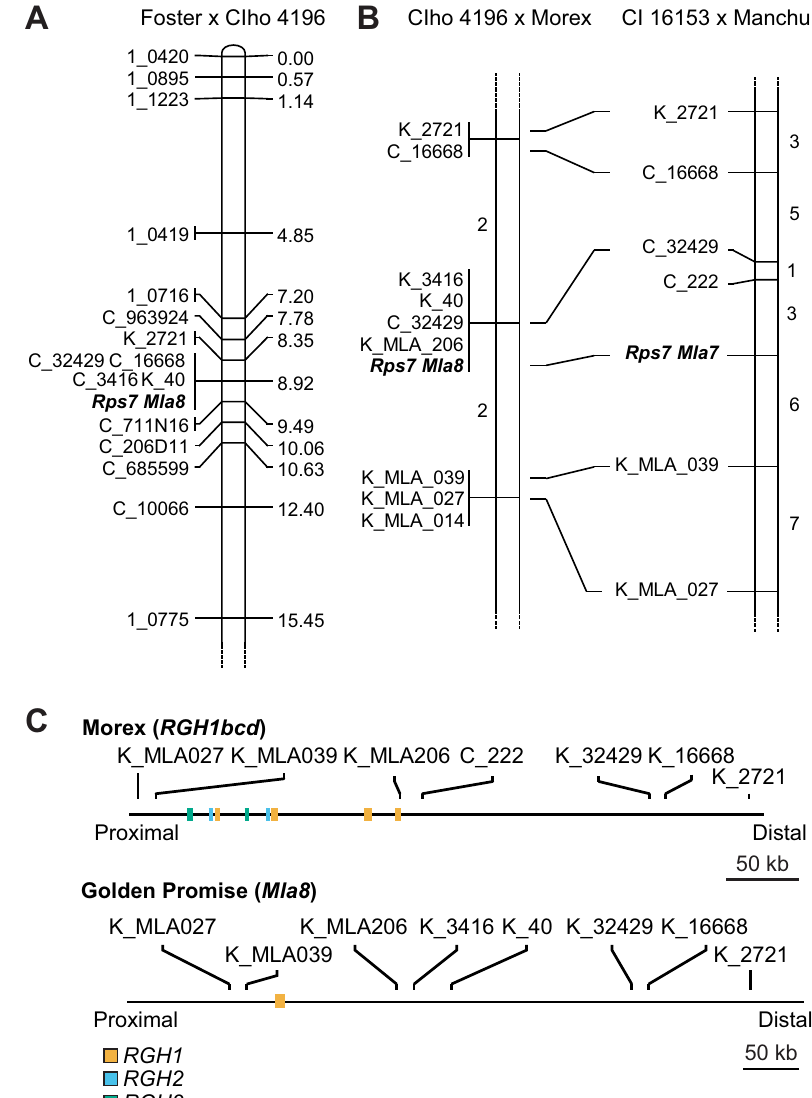
Fig. 3 Rps7 is in complete coupling with Mla . A Genetic map of the Foster × CIho 4196 recombinant inbred line population encompassing the Mla8 /